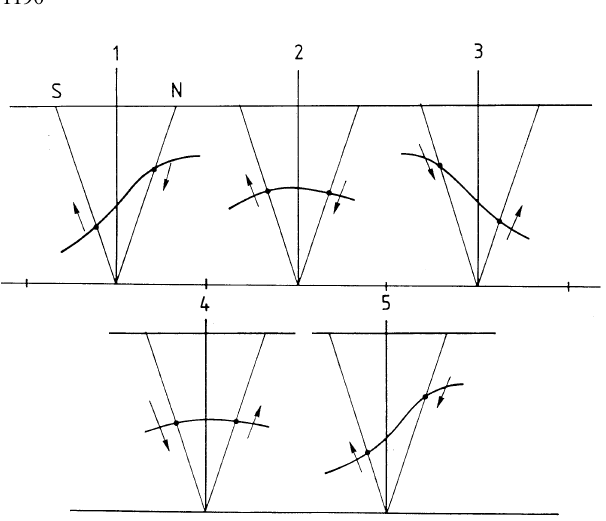
Fig. 7. Schematic sketch of the variation of the height of the echo power maximum in the meridional plane for five consecutive time steps